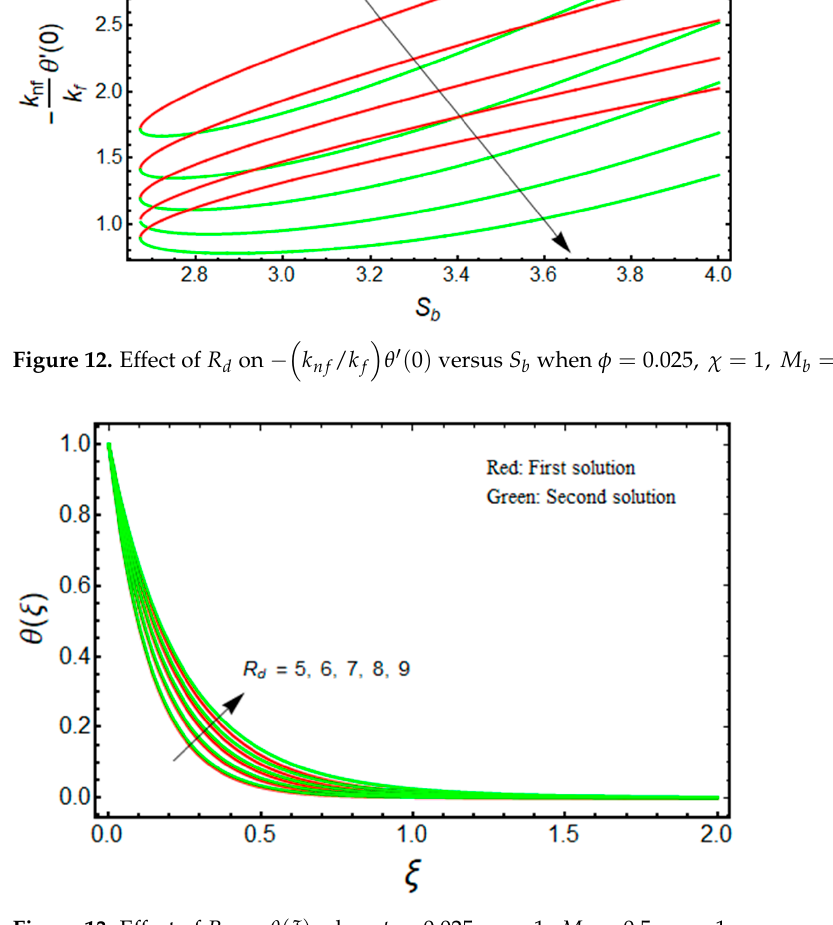
Figure 13. Effect of R d on θ ( ξ ) when φ = 0.025, χ = 1, M b = 0.5, m =